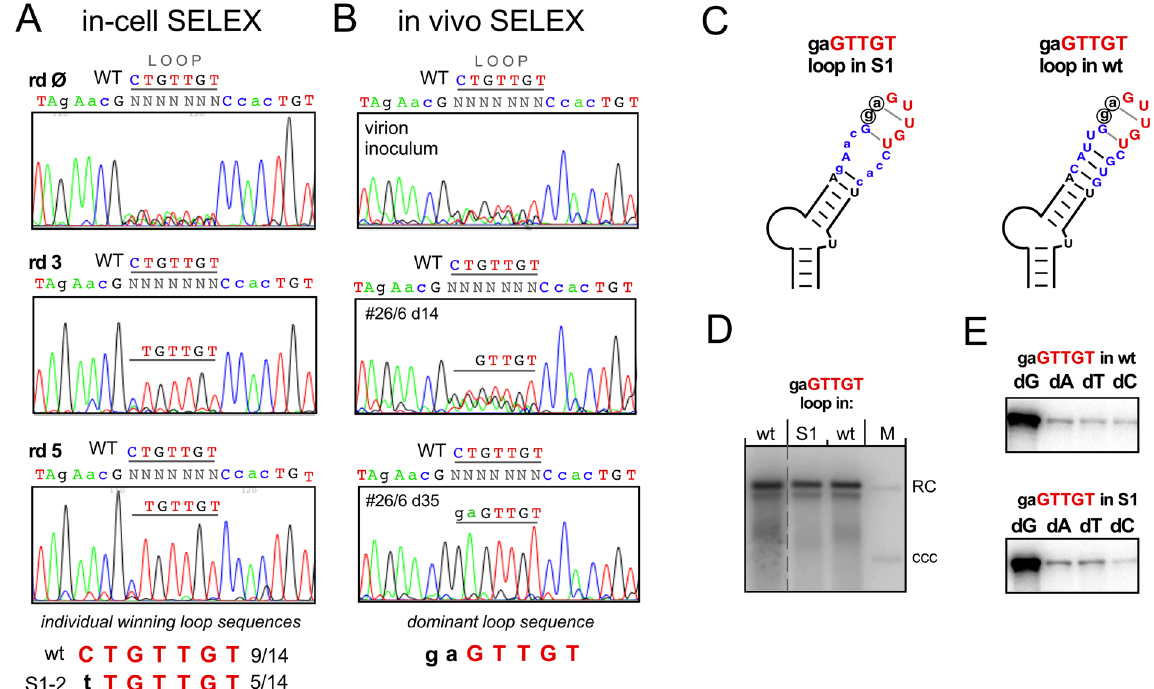
Figure 5. In-cell SELEX and in vivo selection confirm context-independence of the GUUGU motif. SELEX experiments were performed using a starting pool carrying a randomized loop sequence in the context of variant S1 (see Fig. 4A). ( A ) In-cell SELEX pool sequencing chromatograms. As in wt-D ε context sequences carrying the UGUUGU motif were rapidly selected, with some heterogeneity at loop position 1. In the sequence assignments above each chromatogram the S1-specific nt exchanges are indicated by lower case lettering. The winning sequences after round 5 are shown at the bottom. ( B ) Selection of the GUUGU motif in vivo . Two ducklings were inoculated with transfection-derived virions from the round 1 pool. Sequencing chromatograms are derived from the inoculum and serum samples of DHBV-positive animal #26/6 collected on d14 and d35 DNA post inoculation which revealed gaGTTGT as dominant winning loop sequence. ( C – E ) The non-wt gaGUUGU motif is functional in S1 and wt-D ε context. ( C ) Schematic representation of the modified loop sequence in S1 and wt-D ε . ( D ) Wild-type like replication capacity in transfected LMH cells. ( E ) No impact on dNTP specificity during in vitro